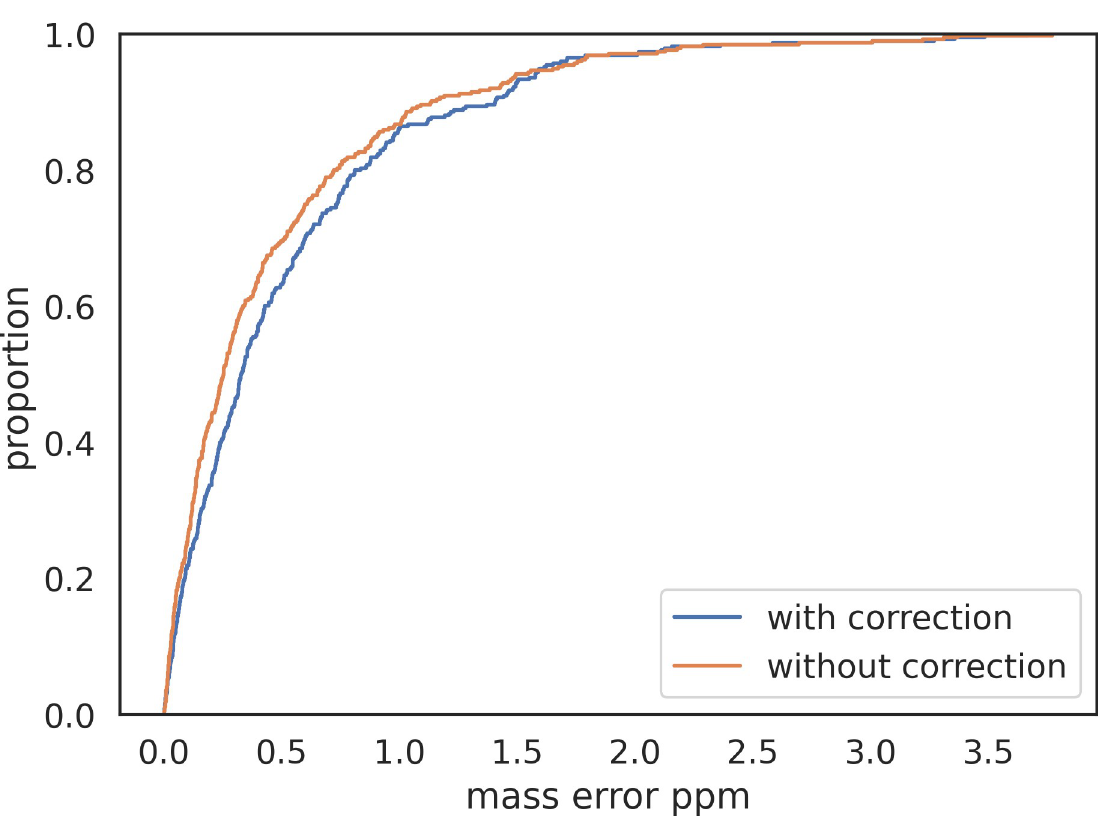
Fig 11. ECDF of mass error for identified peptides with and without correction for